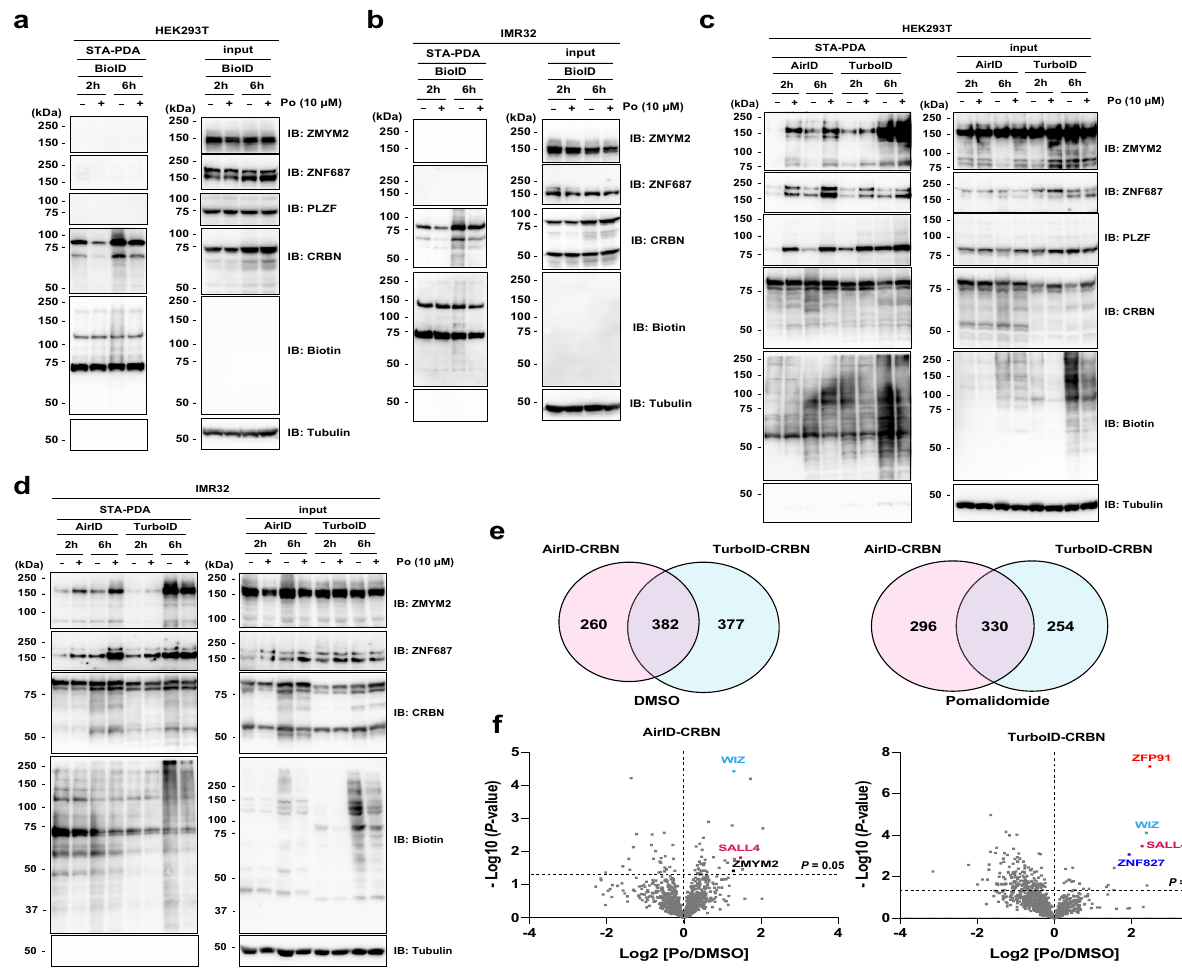
Fig. 5 Comparison of biotinylation enzymes in biotinylation of neo-substrate. a , b IMiDs-dependent biotinylation assay of neo-substrates by BioID-CRBN in a HEK293T or b IMR32 cells. HEK293T or IMR32 cells stably expressing AGIA-BioID-CRBN were treated with DMSO or 10 µ M pomalidomide (Po) in the presence of 10 µ M biotin and 5 µ M MG132 for 2 h or 6 h. The experiments were repeated twice independently with similar results. c , d IMiDs-dependent biotinylation assay of neo-substrates by AirID-CRBN or TurboID-CRBN in c HEK293T or d IMR32 cells. HEK293T or IMR32 cells stably expressing AGIA- AirID-CRBN or AGIA-TurboID-CRBN were treated with DMSO or 10 µ M pomalidomide (Po) in the presence of 10 µ M biotin and 5 µ M MG132 for 2 h or 6 h. The experiments were repeated twice independently with similar results. e Comparison between AirID-CRBN and TurboID-CRBN of biotinylated proteins detected by LC-MS/MS analysis using IMR32 cells. Overlapping biotinylated proteins were compared between AirID-CRBN and TurboID-CRBN